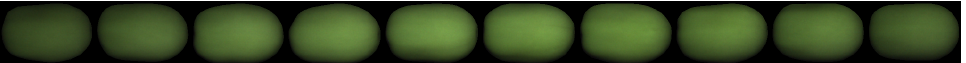
Figure 4. Example of green tomato with no texture. No 3D motion can be estimated in this